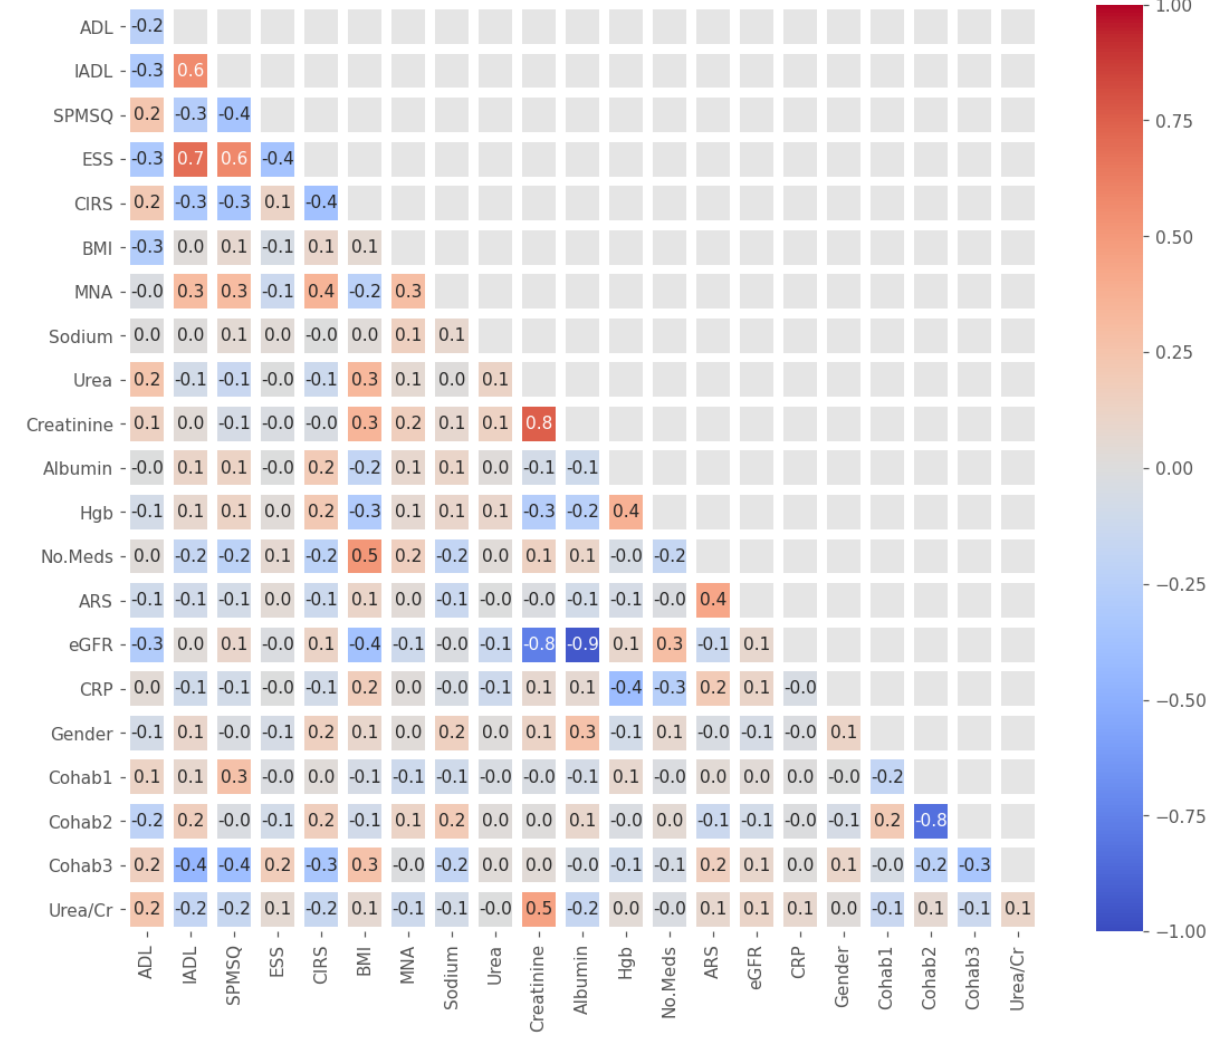
Figure 1. Spearman ρ correlation matrix heatmap for feature set 4. ADL: activities of daily living; ARS: anticholinergic risk score; CIRS: Cumulative Illness Rating Scale; Cohab1: living alone; Cohab2: living with family or friends; Cohab3: living in an institute; CRP: C-reactive protein; eGFR: estimated glomerular filtration rate; ESS: Exton Smith Scale; Hgb: serum hemoglobin; IADL: instrumental activities of daily living; MNA: Mini Nutritional Assessment; No.Meds: number of medications; SPMSQ: Short Portable Mental Status Questionnaire; Urea/Cr: urea-to-creatinine